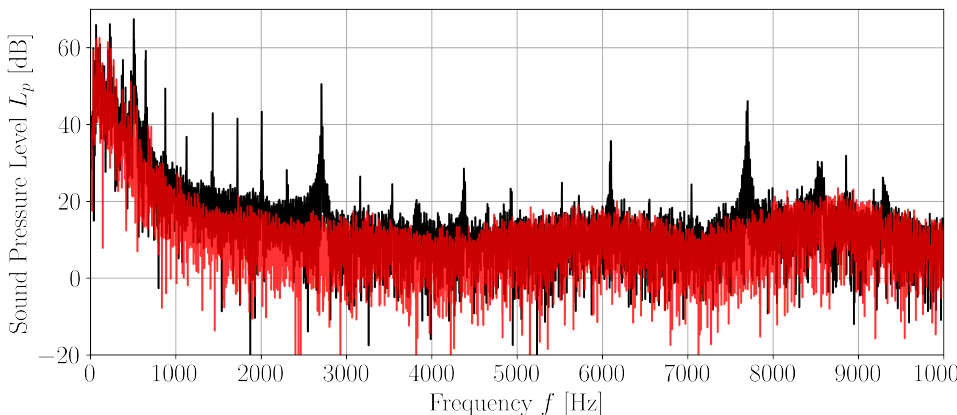
Figure 13. Sound pressure level of cavity noise with flexible PVC walls ( ) and stiff walls ( ).